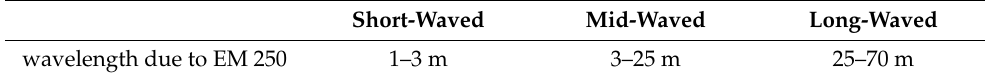
Table 2. Wavelength of the longitudinal level.